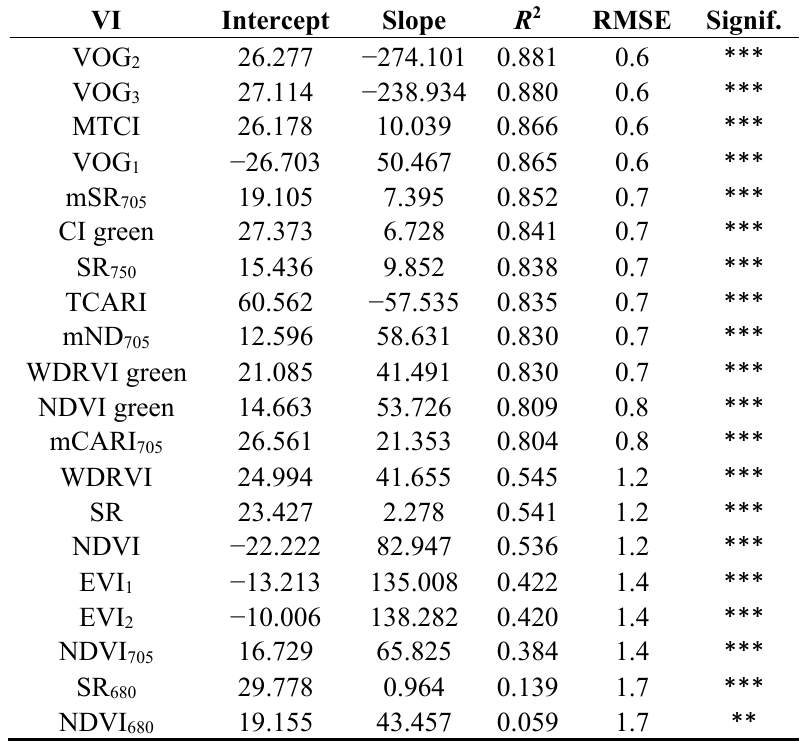
Table 4. Relationship between CC and VIs for L. racemosa ( n = 151).